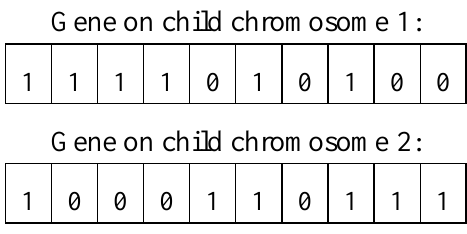
Figure 8. Chromosomes after uniform